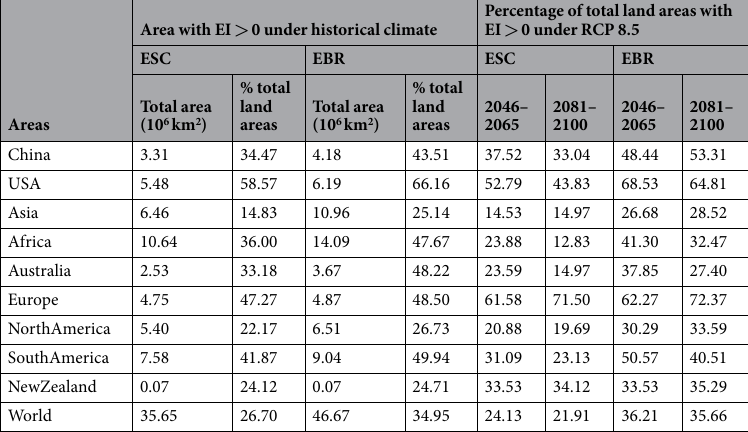
change scenario RCP 8.5, the potential range was projected to expand to the north, reaching approximately 70°N. Similar to those of ESC, areas of potential distribution decreased to the southwest in Australia.